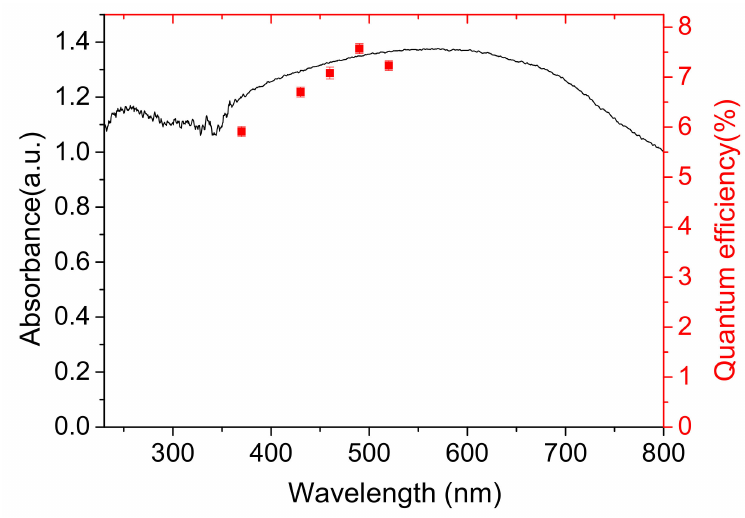
Figure 12. Wavelength-dependent QE for H 2 evolution using 1%PCN@CTF and the UV/Vis absorp- tion spectrum of